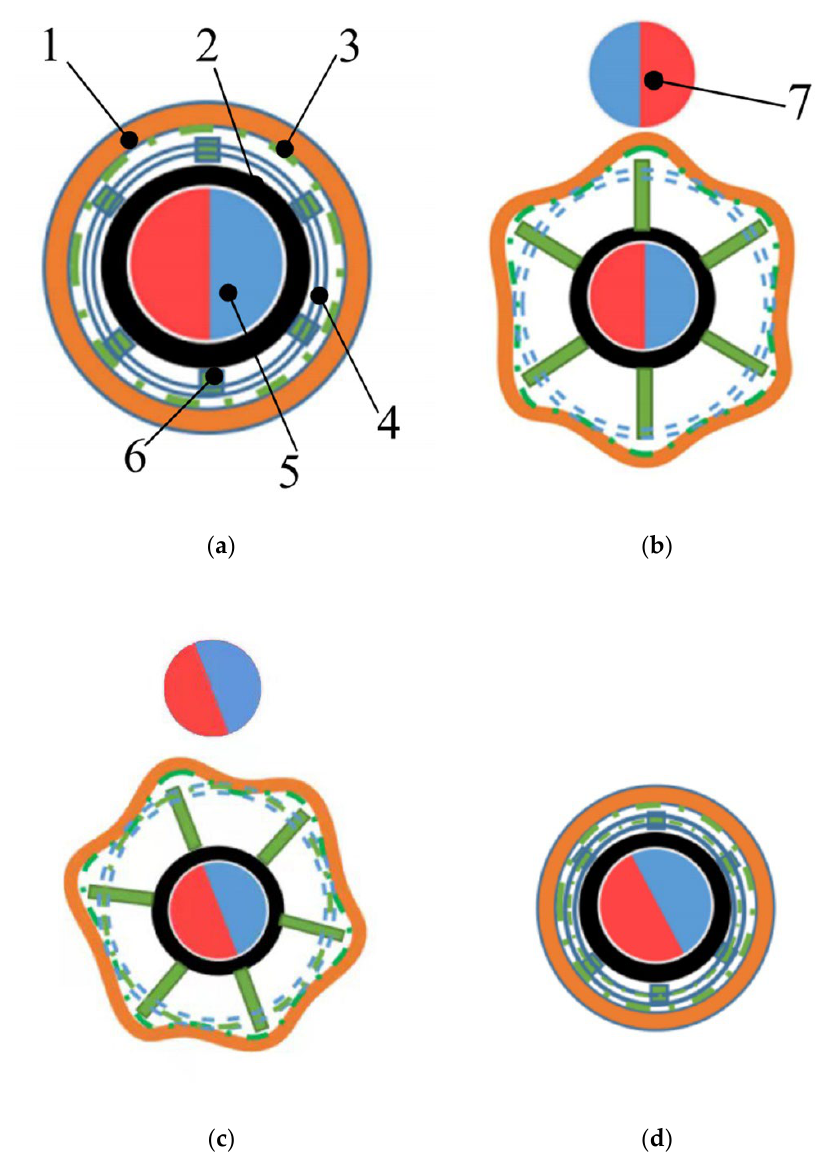
Figure 2. Biopsy process. ( a ) Initial status, ( b ) expanding legs, ( c ) rotating CR, ( d ) contracting legs. 1. Intestine, 2. Capsule shell, 3. Intestinal fluid, 4. Spring, 5. Internal radially magnetized magnet, 6. Leg, 7. External radially magnetized magnet.